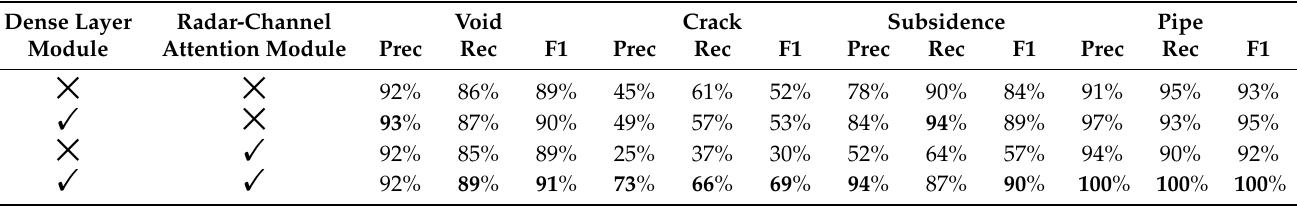
Table 4. Ablation experiments on retention of dense layer module and attention